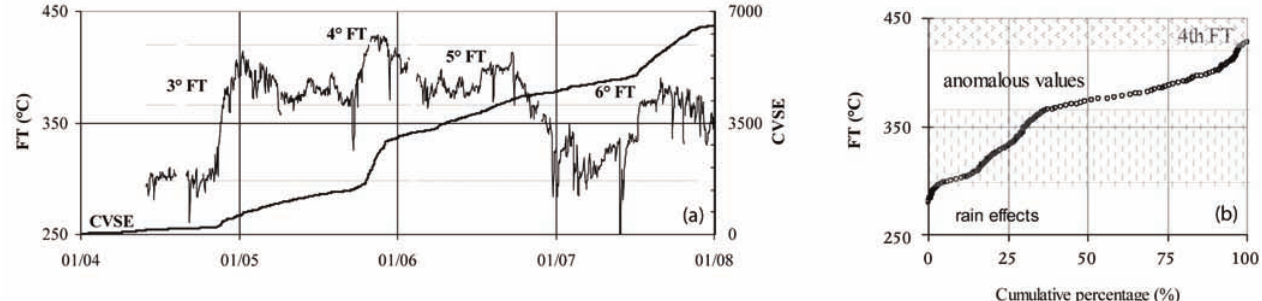
Figure 9. (a) Temperature variations of the F5AT fumarole from 2004 to 2007, and the cumulative number of volcano seismic events (CVSEs) registered at the La Fossa cone (modified from Cannata et al. 2011). The major slope changes of the CVSE occur when the fumarole temperatures increase. The 3 FT to 6 FT peaks in temperature are shown (as in Figure 7b and Table 1). Dashed lines are the threshold values for the F5AT temperatures for (b). (b) Probability plot of the fumarole temperatures and the selected thresholds between different samples of values (dashed lines): 366 ºC is the limit between the two main samples interpreted as the background (25% of the values) and the anomalous temperatures (about 60% of the values). Fumarole temperatures <300 ºC represent background values that are generally disturbed by heavy rain (less than 8% of the data). Fumarole temperatures >420 ºC represent less than 4% of the recorded values, and occurred during the 4 FT geochemical anomaly (November 2005; see (a)). Redrawn from Cannata et al.